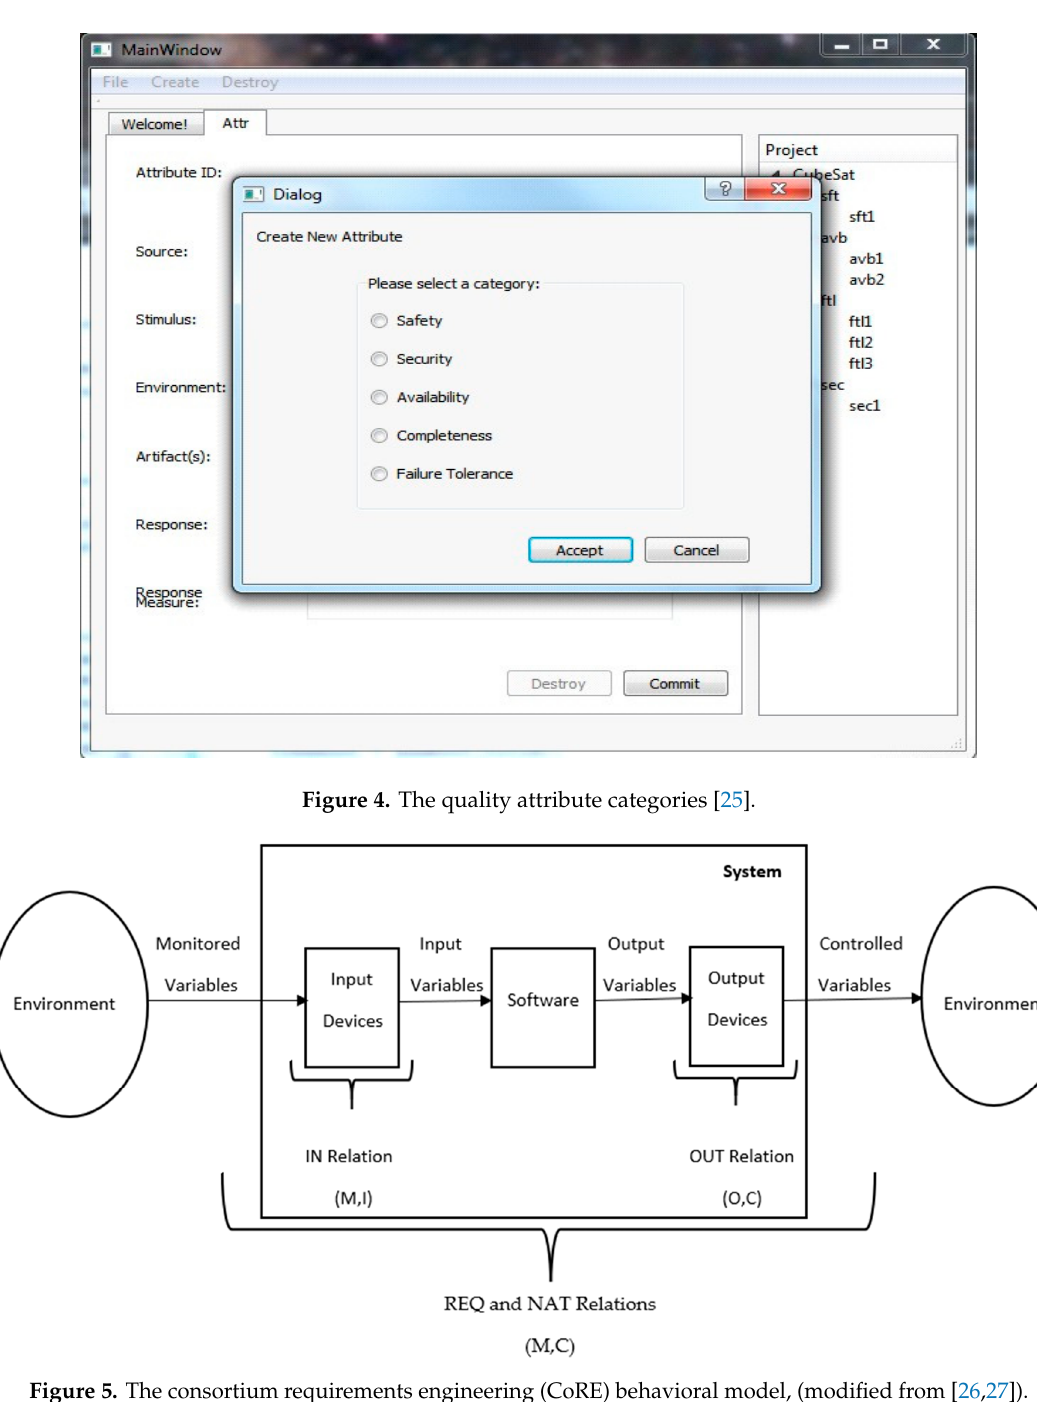
Figure 5. The consortium requirements engineering (CoRE) behavioral model, (modified from